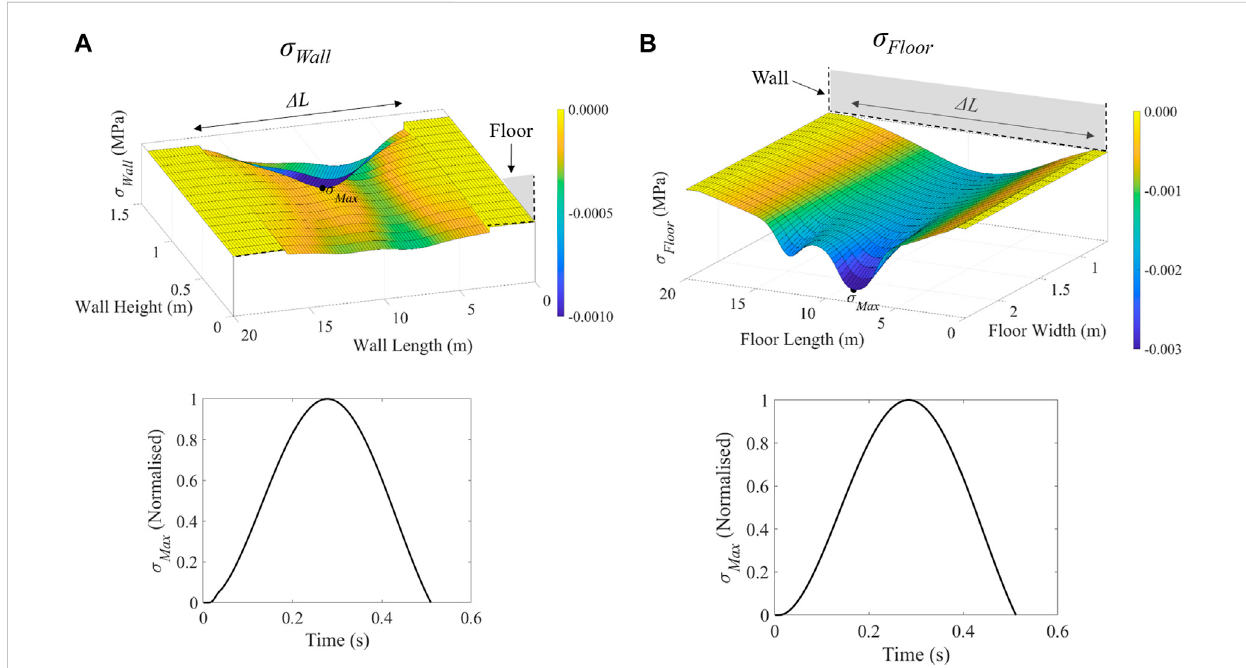
FIGURE 3 Normal stress distributions at the instant of occurrence of maximum net compressive force (top) and time-histories of their maxima ( σ Max ) (bottom) at: (A) masonry quay wall ( σ Wall ) and (B) timber fl oor for a fi re truck ( σ Floor ).